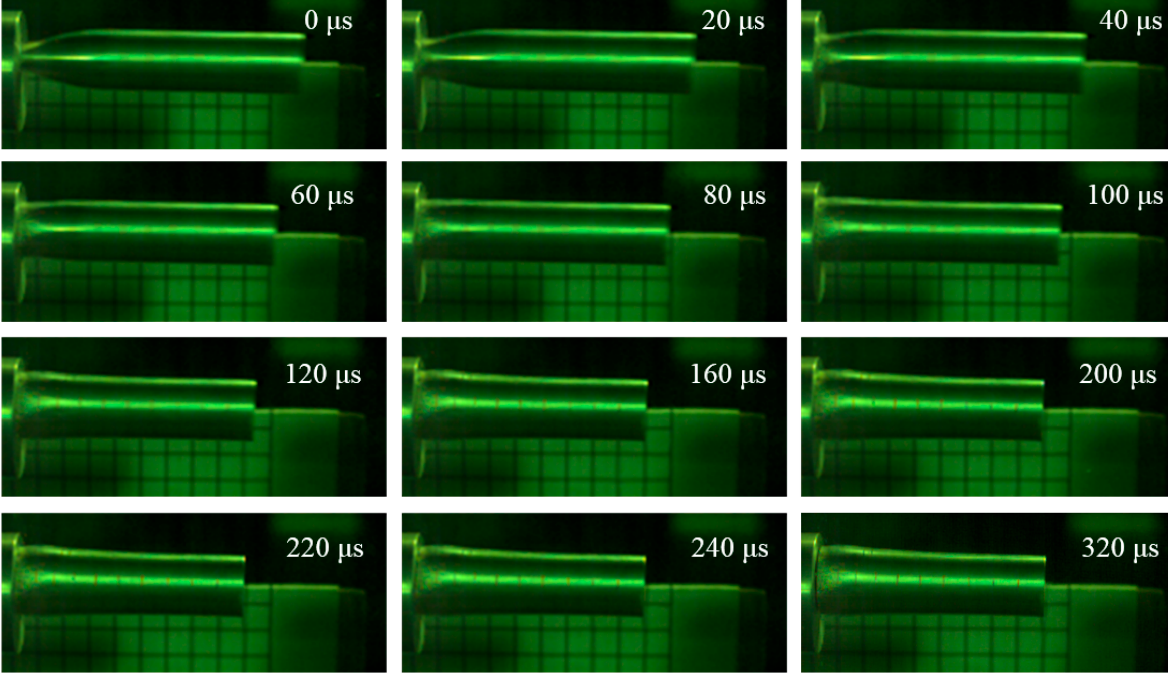
Figure 9. Series of high-speed photographs of the Taylor impact of the truncated ogive projectile (165 m/s).